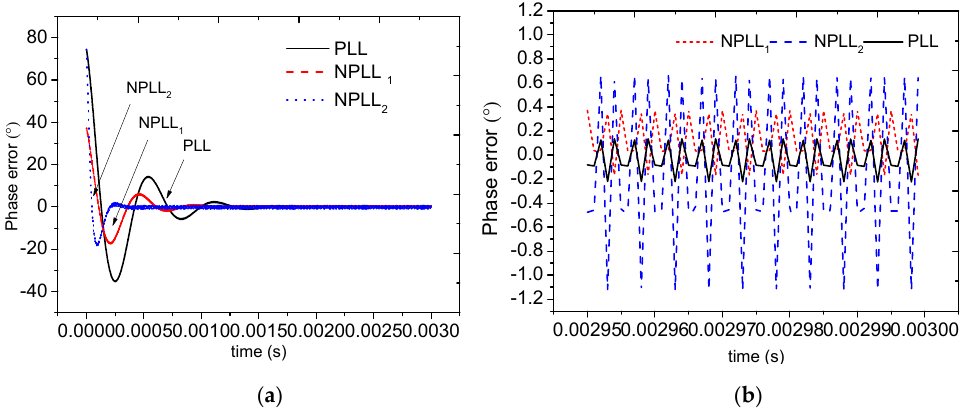
Figure 9. Phase error of PLL under a frequency offset of 1 KHZ: ( a ) phase error of PLL under a frequency offset of 1 kHz; ( b ) phase error of PLL after 2.95 ms.